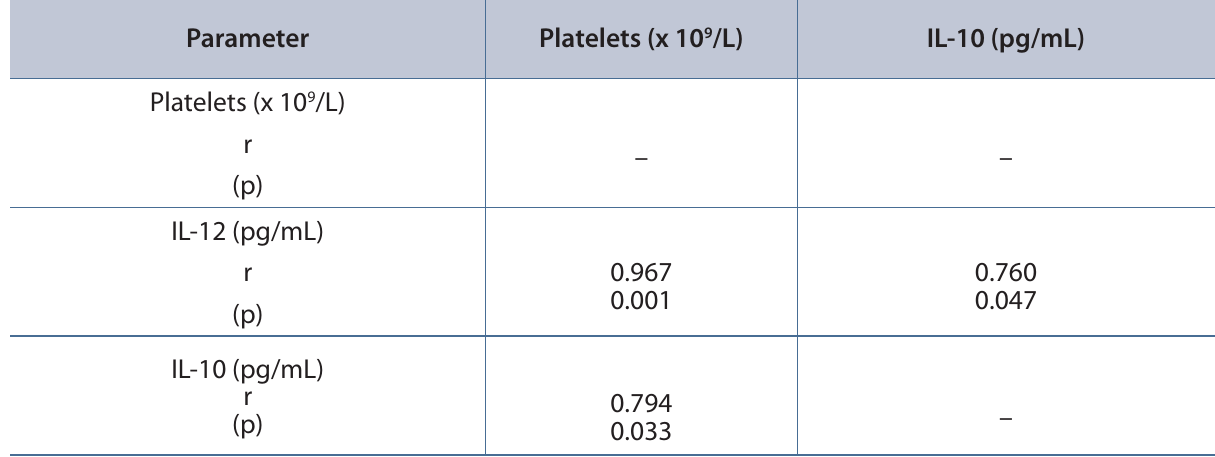
Table 3. Correlations between platelet counts and interleukins 10 and 12 in HCV-positive cirrhotic patients associated with moderate